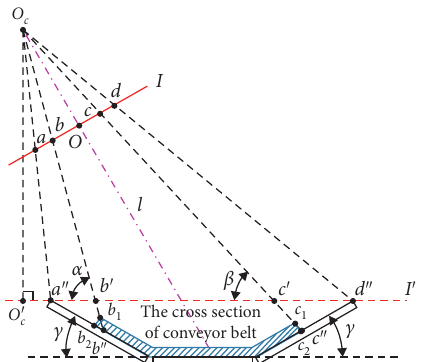
Figure 4: The imaging model of the conveyor belt in the cross- section